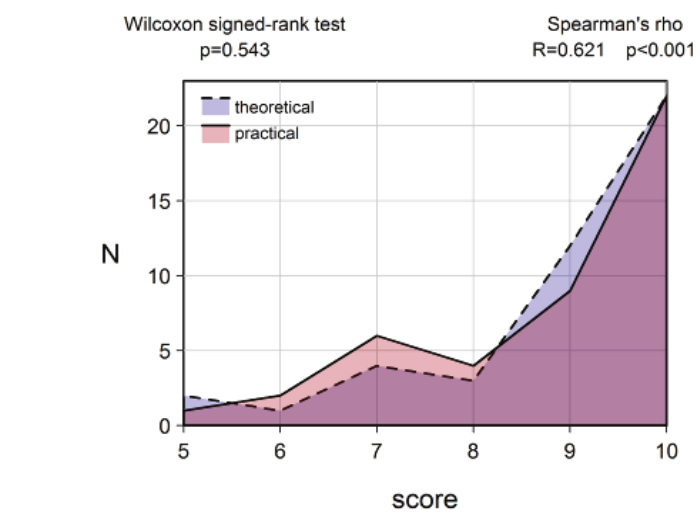
Figure 2 – Outcomes of assessing the ”fire control” assignment Рис . 2 – Результаты оценивания задачи « управление огнем » Слика 2 – Резултати оцењивања задатка „ управљање ватром